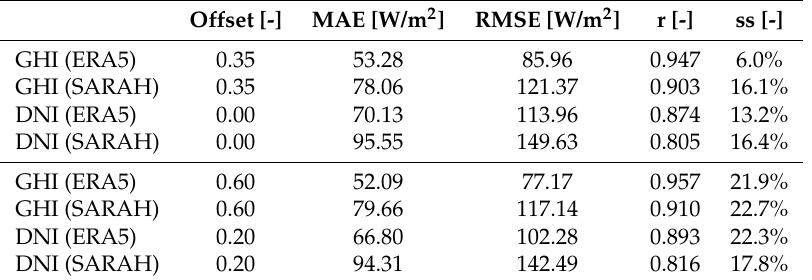
Table 1. Errors for the irradiation model for GHI and DNI, for ERA5 and SARAH datasets, and for the original and optimized offset parameter.